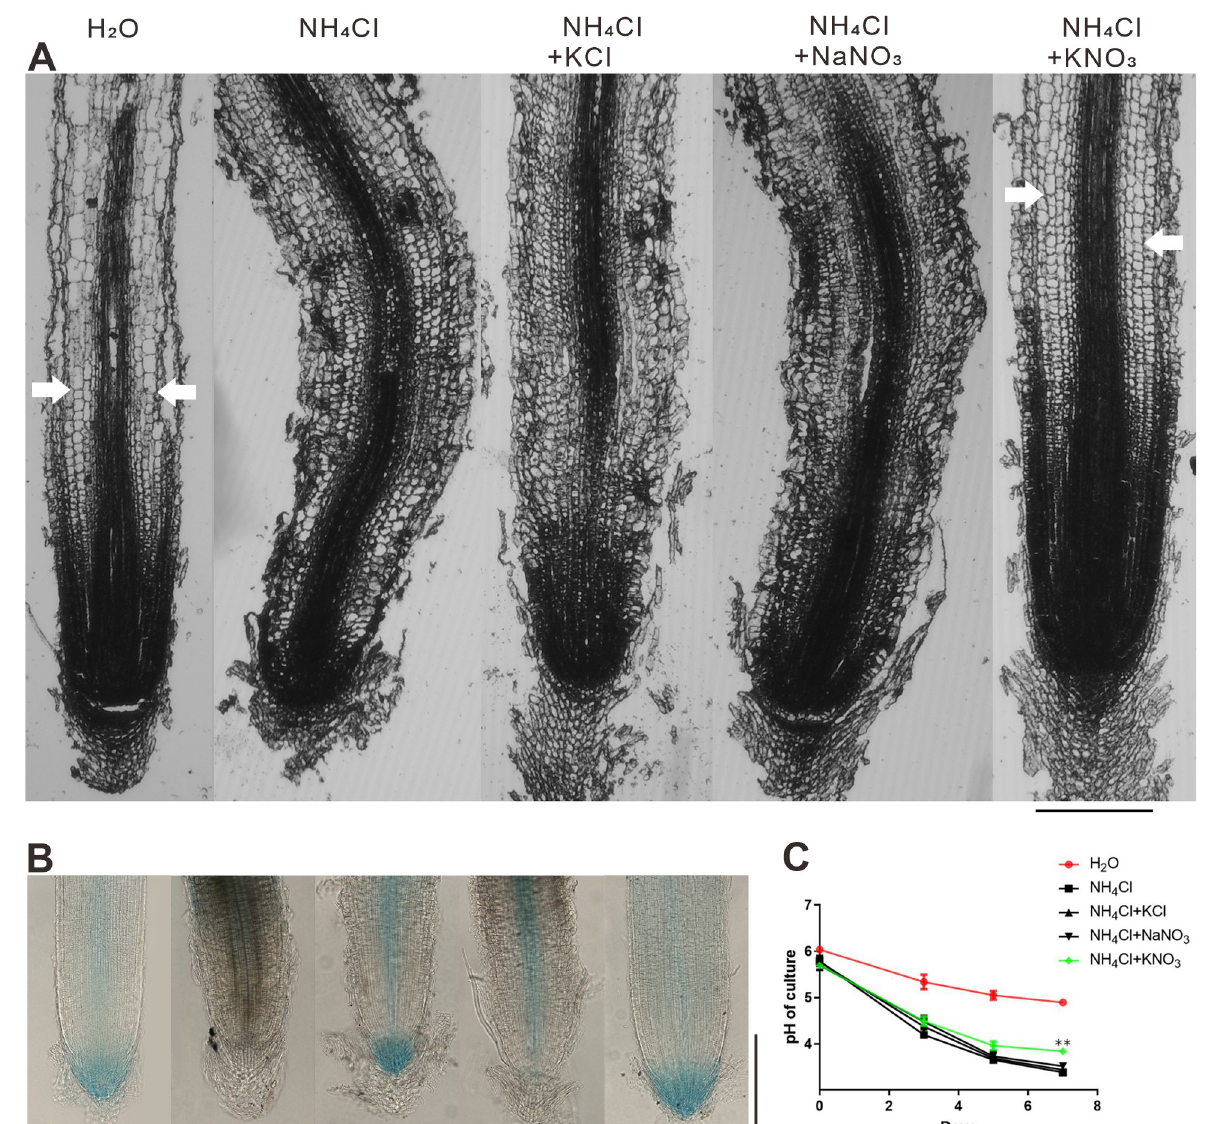
Fig 3. Morphology, auxin responsiveness, and rhizosphere acidification. (A) Micrographs of paraffin sections of radicles from 7-day-old seedlings. The approximate boundary of the elongation zone is marked by white arrowheads. (B) Micrographs of 7-day-old roots expressing DR-5:: GUS, stained for GUS activity. In A and B, roots shown are the roots representative, selected from 10 seedlings in each treatment. Scale bars = 50 μ m. (C) The pH of the culture solutions was measured every 2 days from the 3 rd day after seed germination. Data are the mean ± SD; t- tests were used to identify significant differences; �� (p < 0.01) represent significant differences between each alleviation treatment and ammonium toxicity treatment.